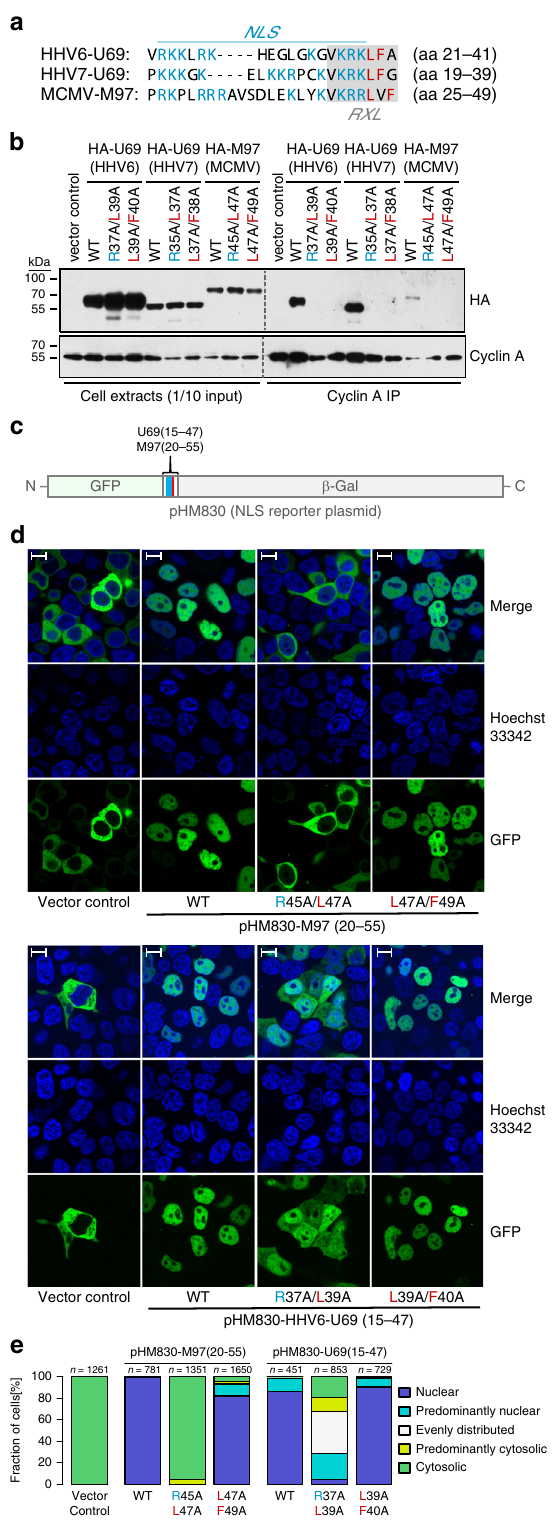
Next, we studied how the dynamic and Cyclin A-dependent relocalization of M97 impacts protein phosphorylation. There- fore, we compared cells that were either infected with RXL de fi cient MCMV-M97 L47A/F49A or NLS-RXL de fi cient MCMV- M97 R45A/L47A . The two mutant viruses re fl ect the early nuclear or late cytosolic localization of M97 during MCMV-WT infections.